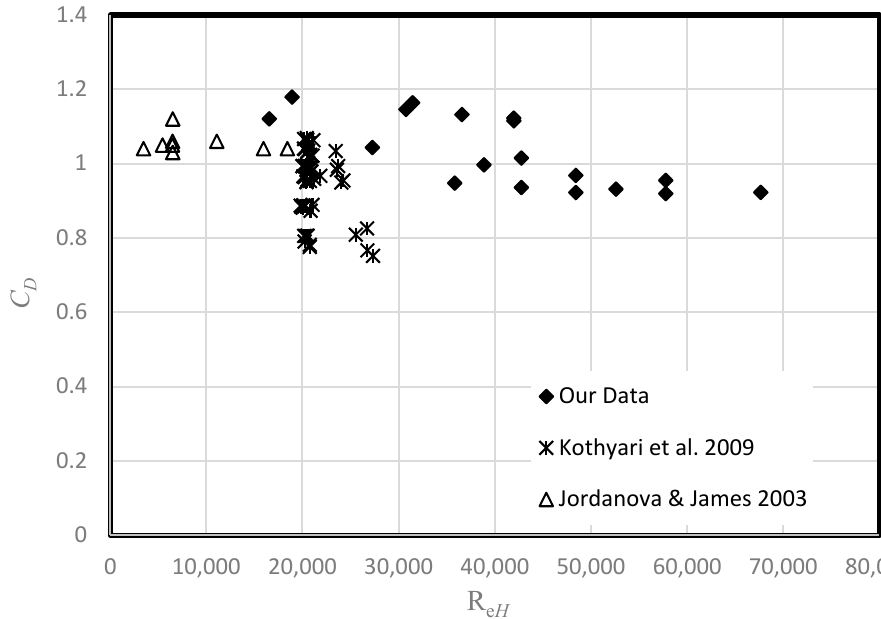
Figure 12. C D versus flow Reynolds number [11, 12].